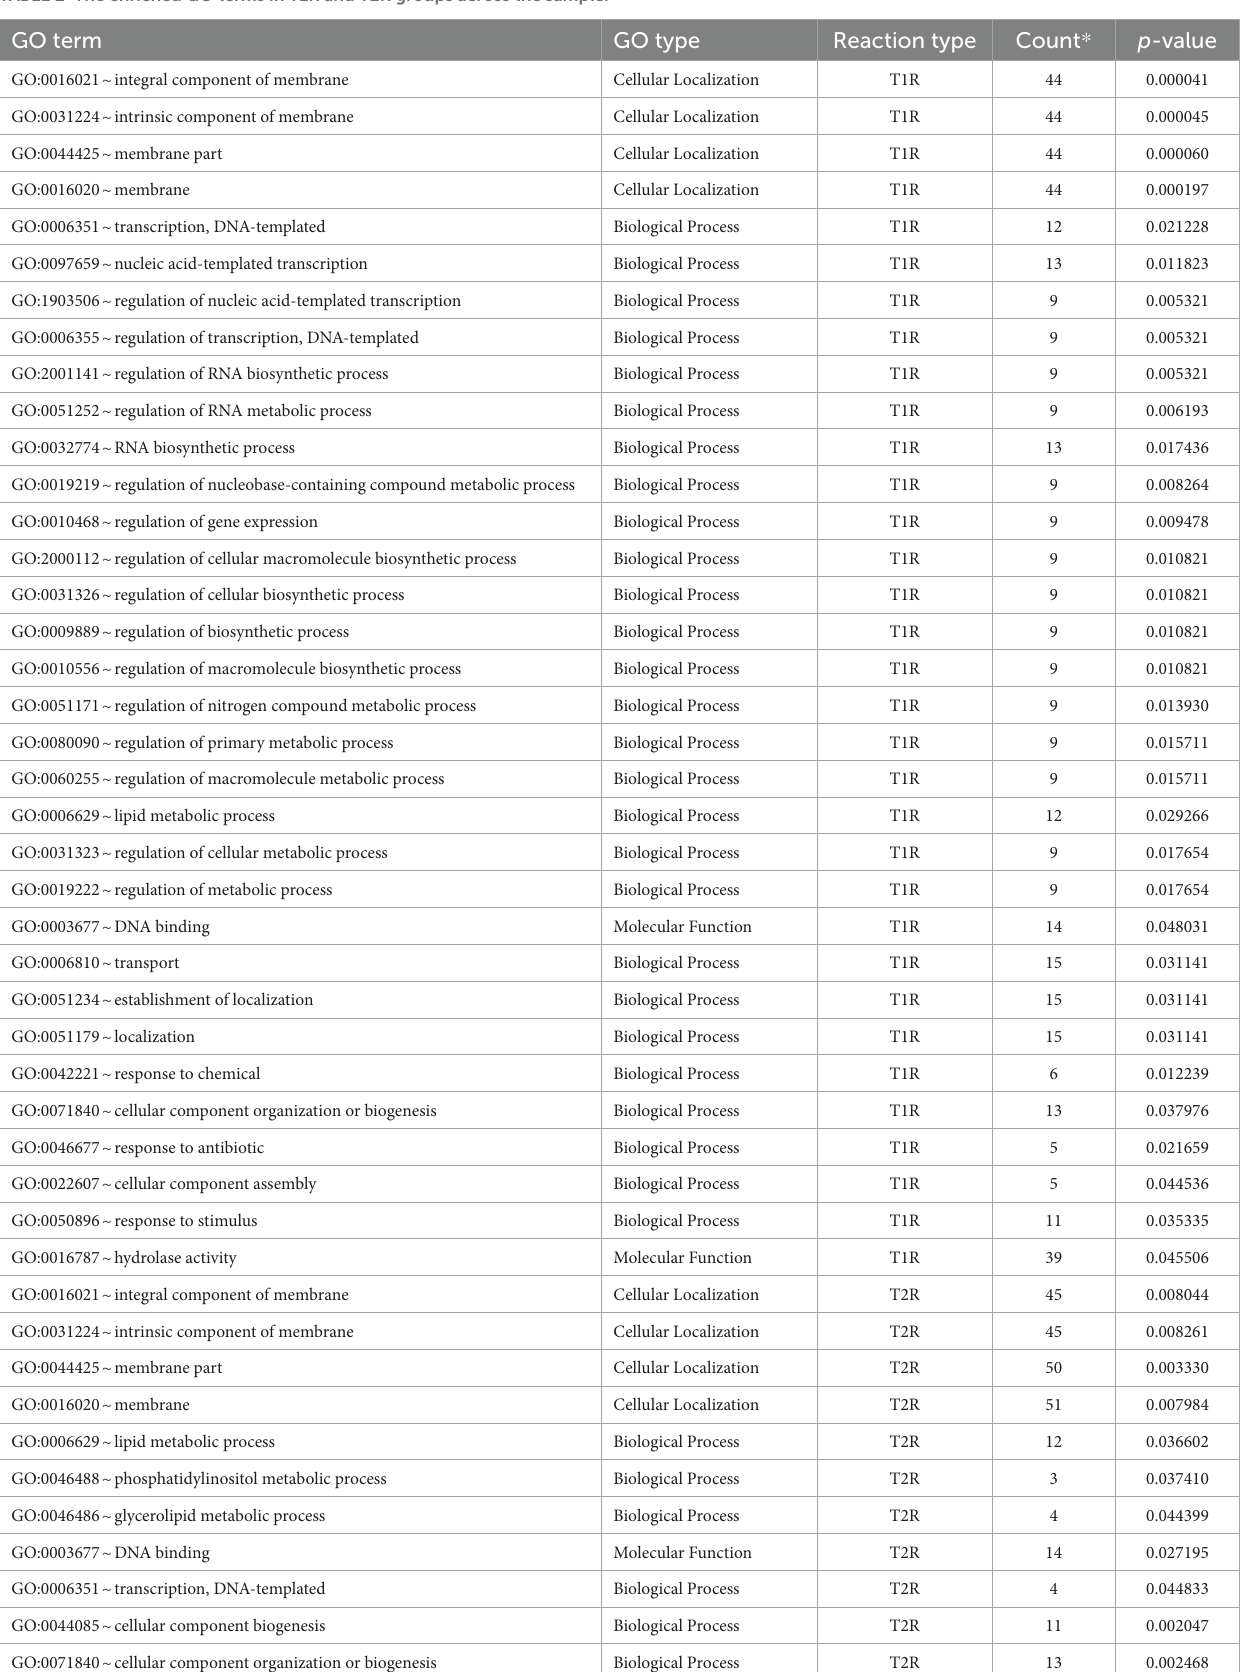
TABLE 2 The enriched GO terms in T1R and T2R groups across the